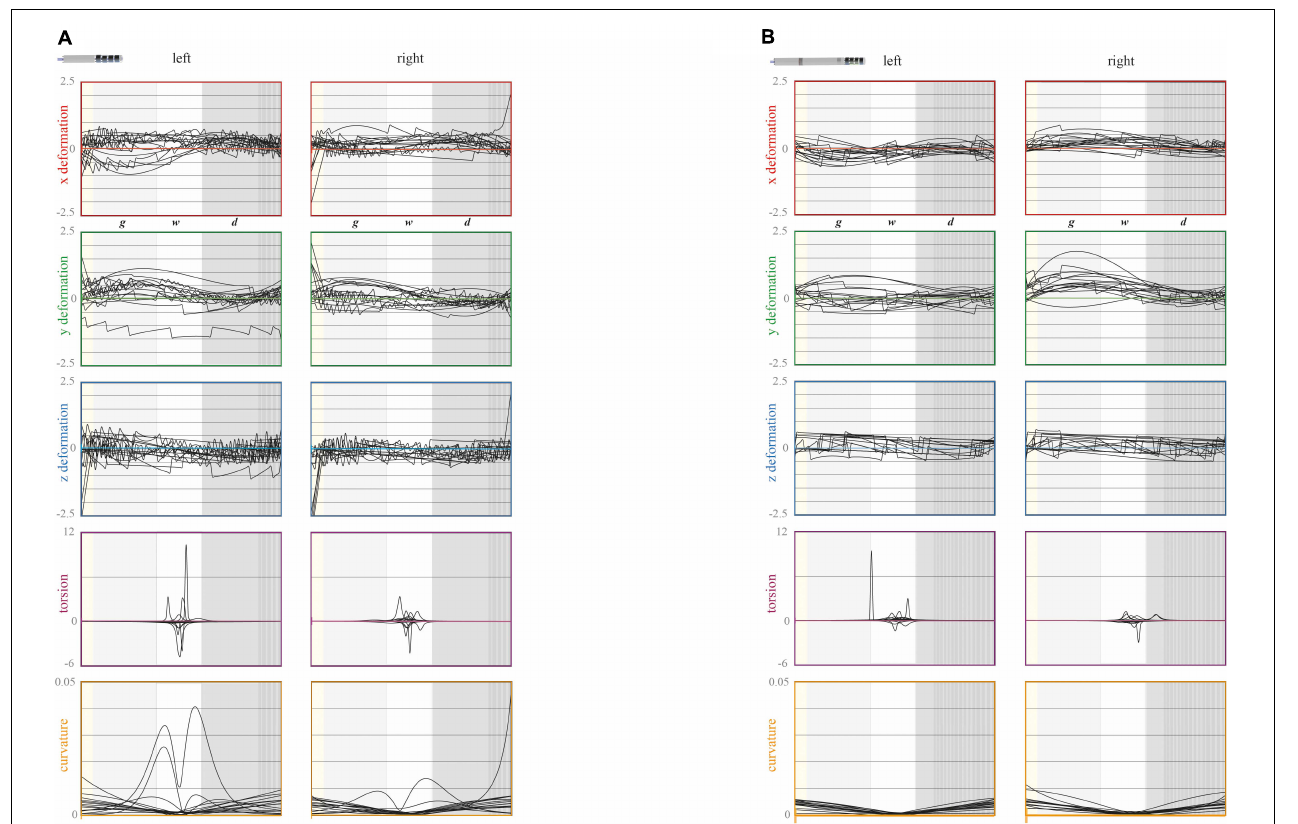
FIGURE 9 | Deformation parameters of the electrode models. ( A , non-directional, n = 30; B , directional, n = 30; 15 electrodes per hemisphere, right and left), from top to bottom: x (red), y (green), and z (blue) deformation values (from –2.5 to 2.5 mm) of the skeleton (see text for details); torsion (purple; from –6 to 12 mm − 1 ) and curvature (orange; from 0 to 0.05 mm − 1 ) values along the electrodes; abscissa, depth along the electrode crossing the subdural space (yellow), the gyration layer (light gray), the white matter stem (pale gray), and the deep brain (dark gray) (proportional display); the distal rigid part of electrodes is overlaid (vertical